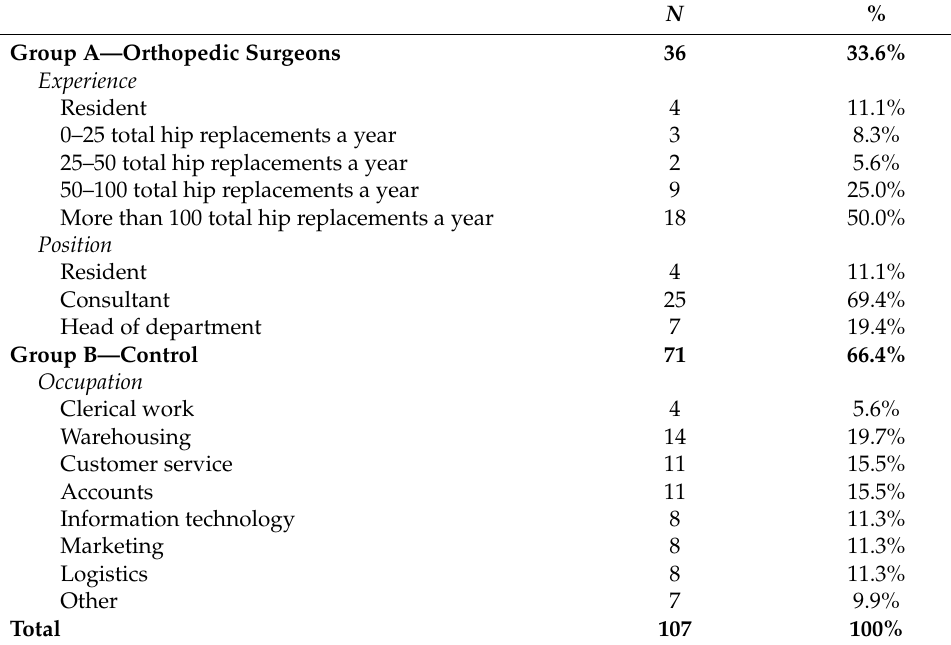
Table 1. Description of the groups.